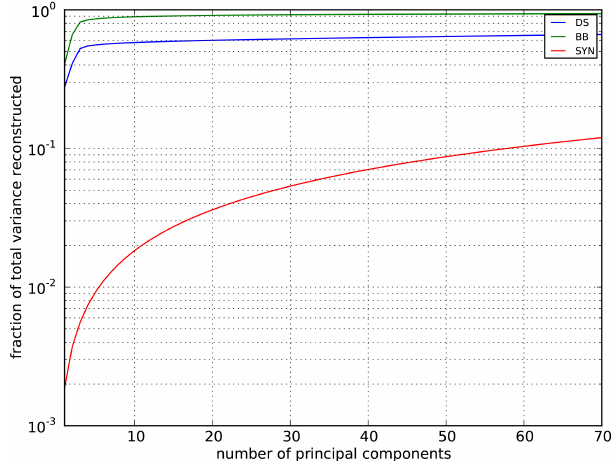
Figure 11. Cumulative normalised covariance eigenvalues, i.e. the cumulative sum of the values shown in Fig. 10. These indicate the relative variance restored after reconstructing the image from a given number of principal